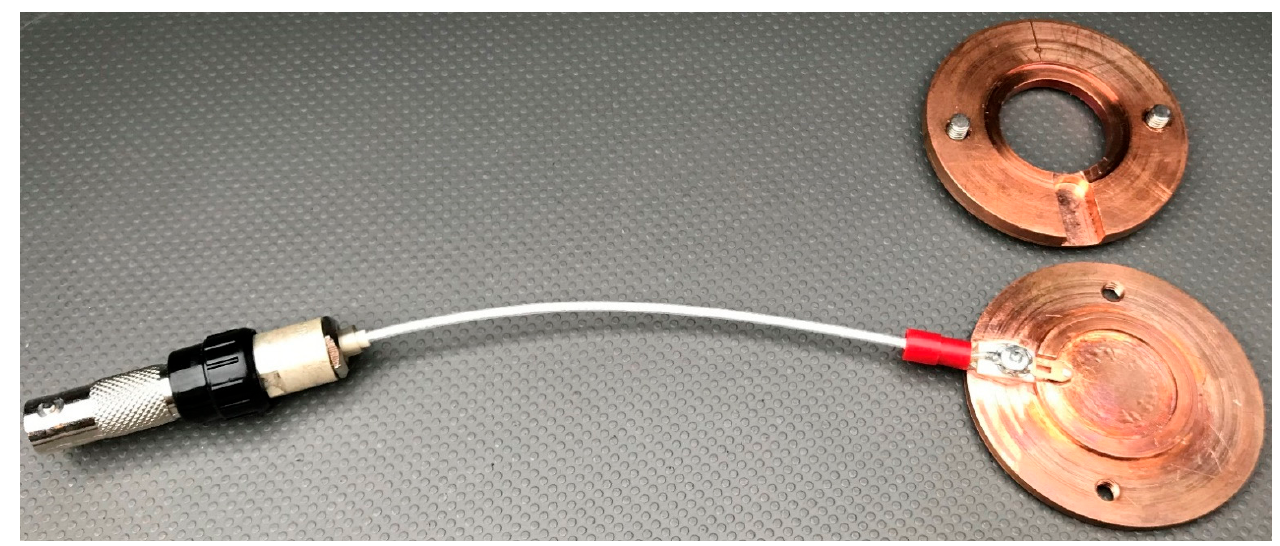
Figure 2. A custom copper-based QCM holder developed in “Acoustoelectronics” Laboratory at ISSP-BAS.